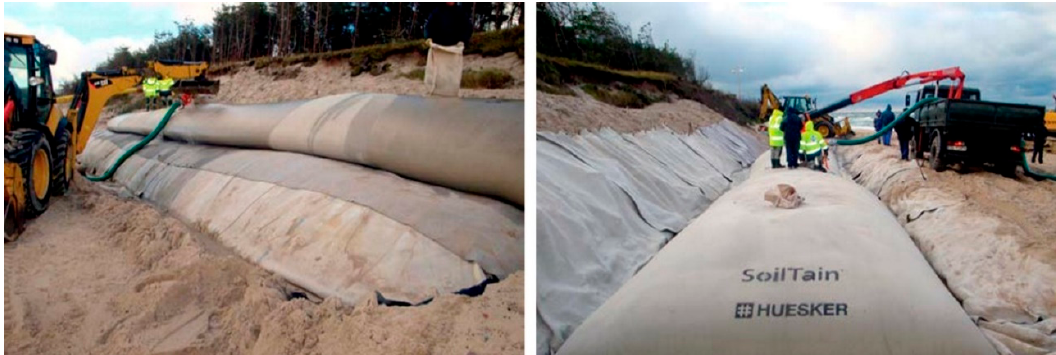
Figure 1. SoilTain ® tube during construction works in Rowy, https://www.huesker.co.uk.